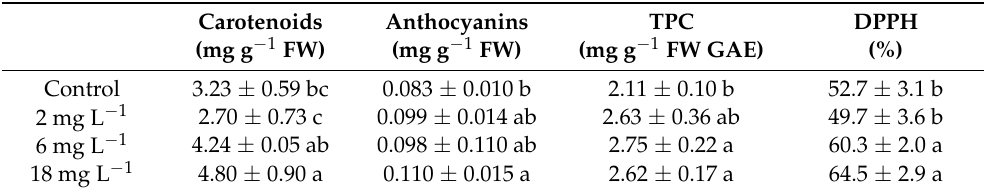
Table 2. Carotenoids, anthocyanins, total phenol content (TPC), and radical scavenging rate (DPPH) found in olive proliferated